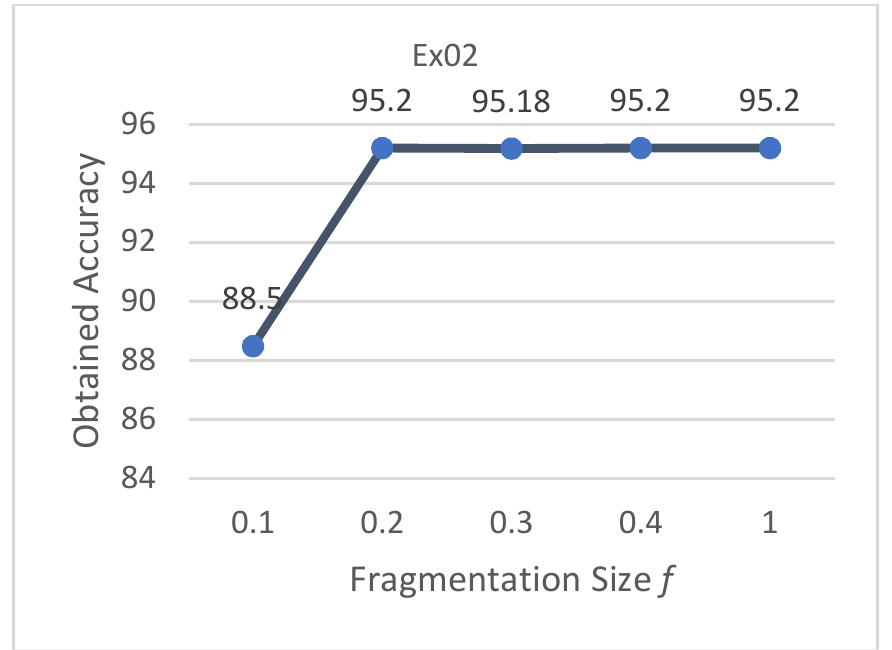
Figure 11. The reported accuracy scores of biomarker detection upon sequence fragmentation (f = 0.1, 0.2, 0.3, 0.4, 1) using Model_I and Dataset_I (EX02).